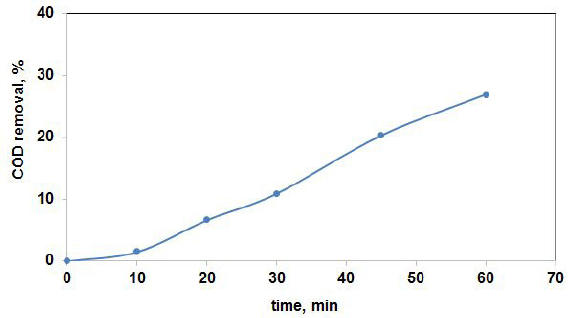
Fig. 10. Variation of COD with time (initial dye concentration: 0.04g/L, pH: original, initial temperature: 25 °C, H 2 O 2 amount:2.78 g/L, m-ZZF amount: 3 g/L, CaCl 2 amount: 3.75 g/L, UV light)